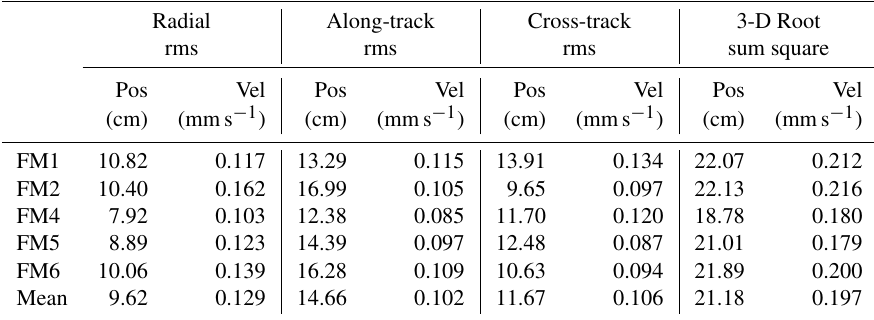
Table 1. The rms of COSMIC satellites compared with UCAR/CDAAC on three axes. Radial Along-track Cross-track 3-D Root rms rms